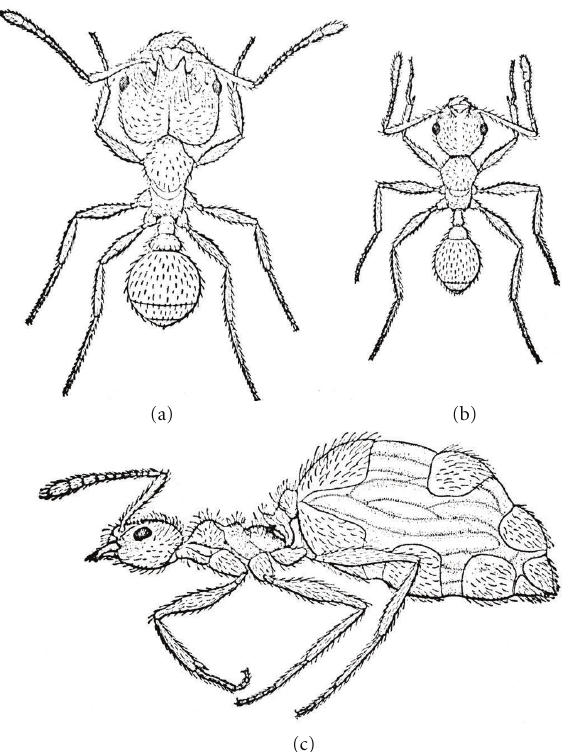
Figure 6: Plate (modified) of Pheidole dentata (referred to as P. commutata ) from [18] showing the first evidence that mermithid nematodes could cause intercastes of ants. (a) Normal soldier; (b) normal worker; (c) parasitized worker